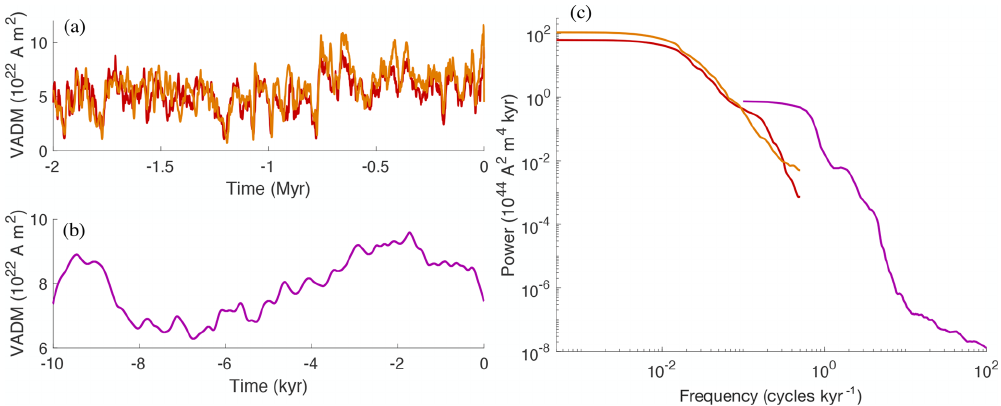
Figure 1. Data used in this paper. (a) Sint-2000 (orange) and PADM2M (red): VADM as a function of time over the past 2Myr. (b) CALS10k.2: VADM as a function of time over the past 10kyr. (c) Power spectral densities of the data in (a) and (b) , computed by the multi-taper spectral estimation technique of Constable and Johnson (2005). Orange: Sint-2000. Red: PADM2M. Purple: CALS10k.2.